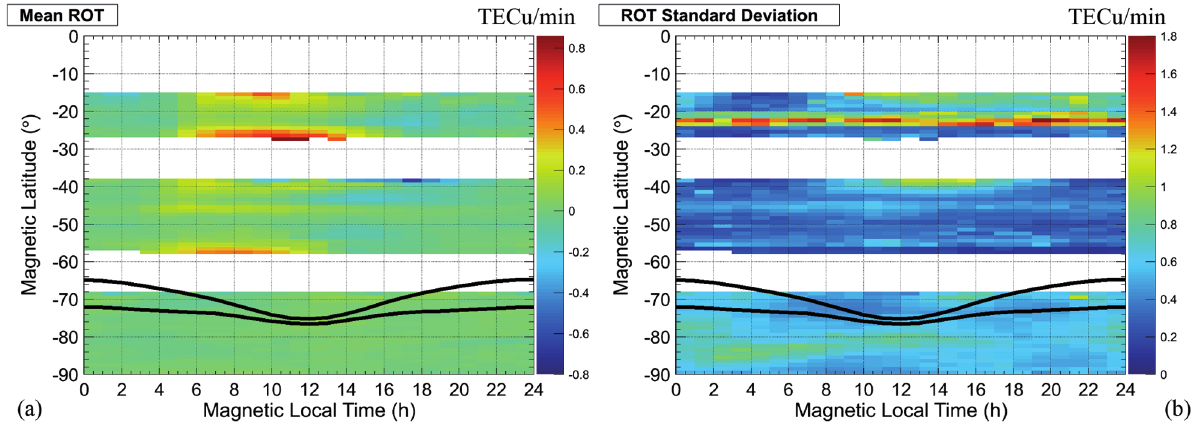
Figure 6. Maps of mean (a) and standard deviation (b) of ROT. The black curve is the modeled Feldstein oval for IQ =